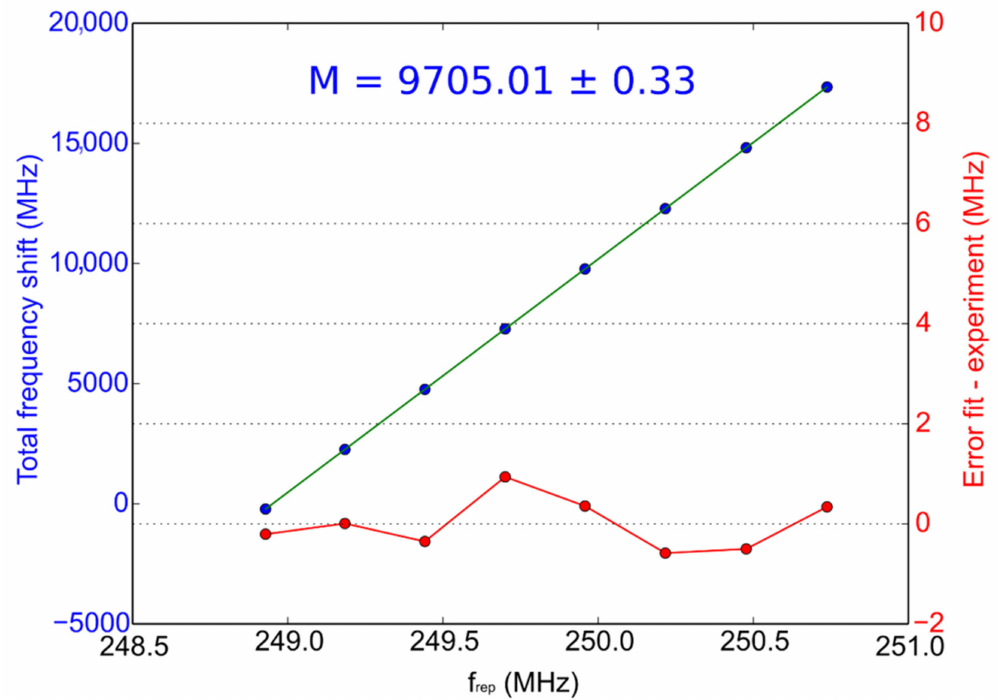
Figure 7. Retrieval of the optically rectified frequency comb (OR-comb) mode number M relative to Equation (1). The frequency of the QCL-comb mode involved in the beating is kept constant by fixing the device driving current and operational temperature. The frequency of the down converted beatnote HBN is acquired and plotted as a function of the optically rectified comb repetition rate (f rep ). As a consequence, the order M is extracted from the slope of the data linear regression, by rounding to the nearest integer, i.e., M = 9705. The fit residuals, plotted in red, confirm the 1 MHz uncertainty in the determination of the f HBN